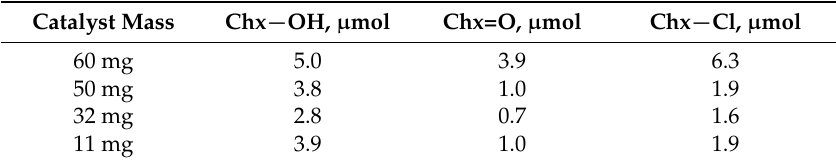
Table 5. Photolysis of cyclohexane, reusing catalyst from previous run: 1 mL cyclohexane (0.5% acetic acid, 1 mg Bu 4 NBr, 50% O 2 /50% air balloon) with 60 mg Et 4 N[FeCl 4 ] initially, irradiated (100 W Hg lamp, λ > 345 nm) for 20 min.